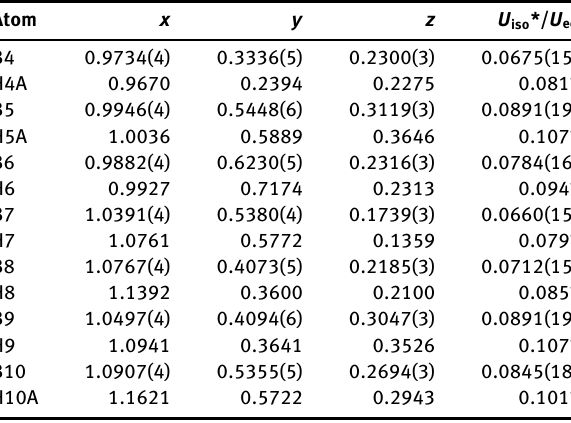
Table 2: Fractional atomic coordinates and isotropic or equivalent isotropic displacement parameters (Å 2 ).